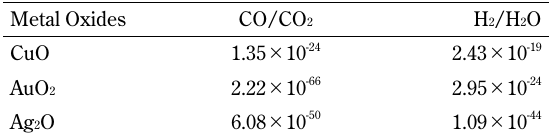
Table 4 The ratio of CO/CO 2 or H 2 /H 2 O for prevention of these oxides from oxidation.[Thermodynamic data for calculations were taken from references 19,20 ）